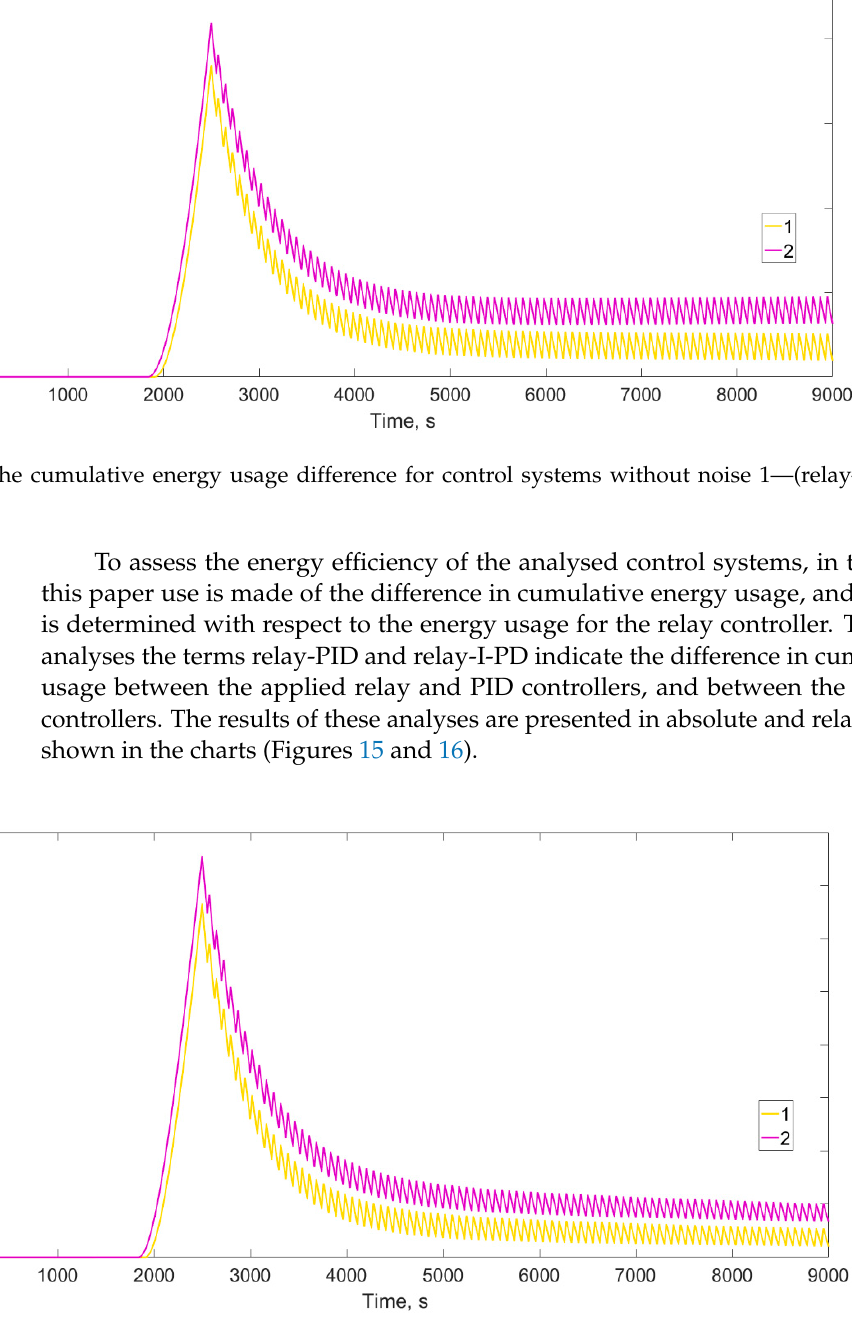
Figure 14. Total energy usage for control systems in the presence of a random noise signal with a maximum amplitude of 3% for the different controllers: 1—relay and 2—PID, 3—I-PD.